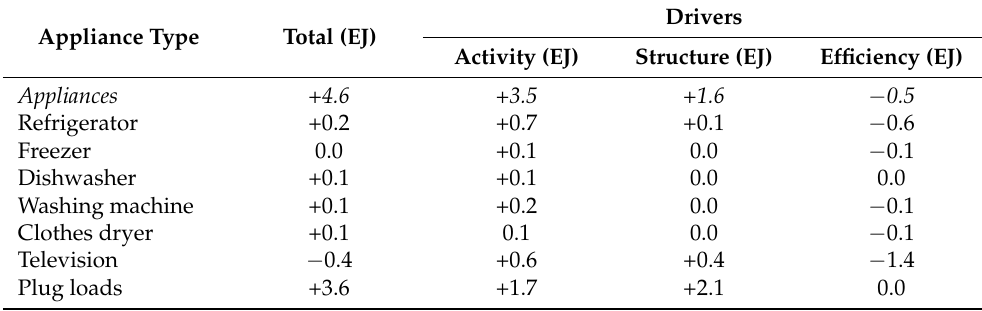
Table 1. Worldwide energy intensity improvements in appliances in the period 2000–2017 [6].